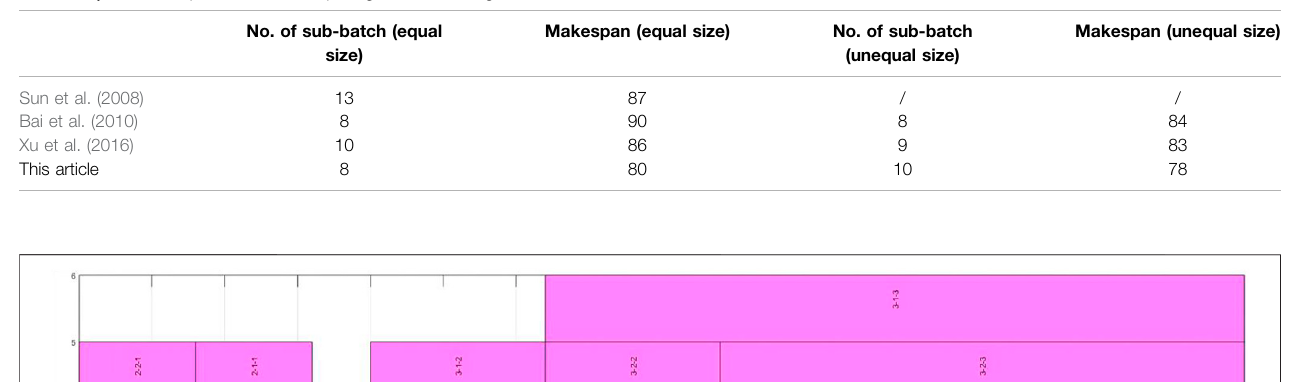
TABLE 2 | 4 × 6 Comparison of batch splitting and scheduling results.